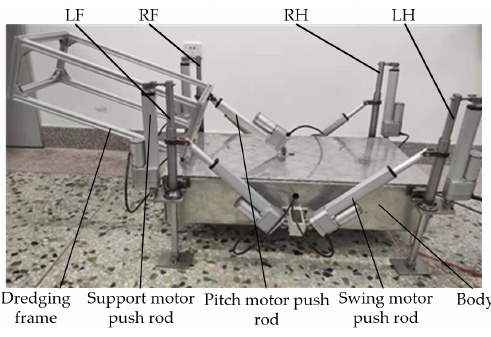
Figure 14. Experimental prototype.